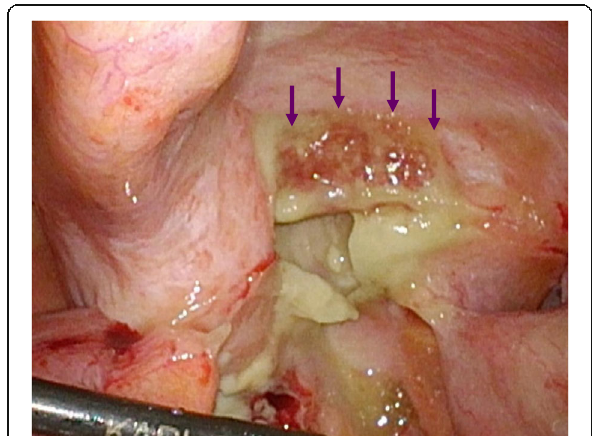
Fig. 3 Laparoscopic findings. The appendix (purple arrows) was swollen, and pus collection was observed